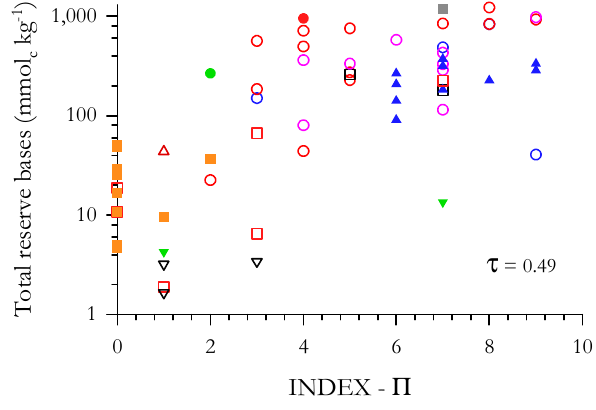
Fig. 14 Fig. 14. Relationship between the index of physical properties ( 5 ) and the chemical weathering index Total Reserve Bases ( P RB ). Note that only Y-axis is in logarithmic scale. Values of Kendall’s τ rank correlation coefficient are also shown.